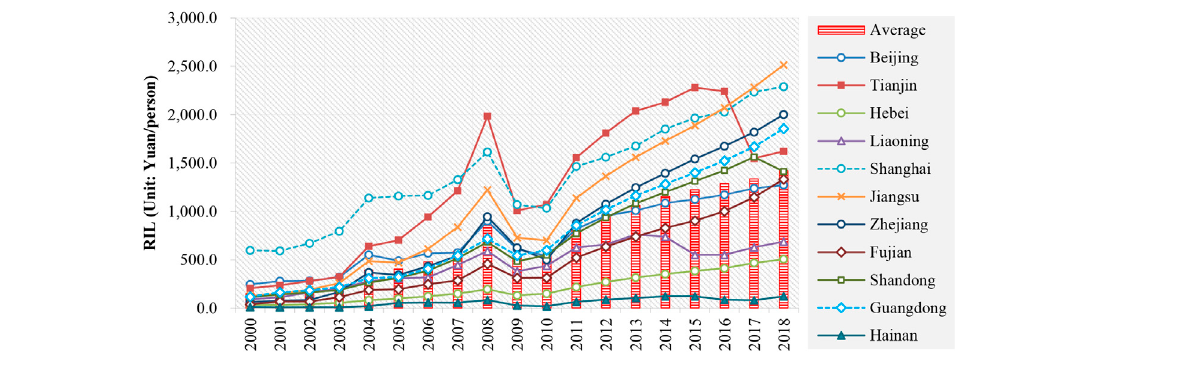
FIGURE 4 | Changes in RIL in eastern China in 2000 – 2018.